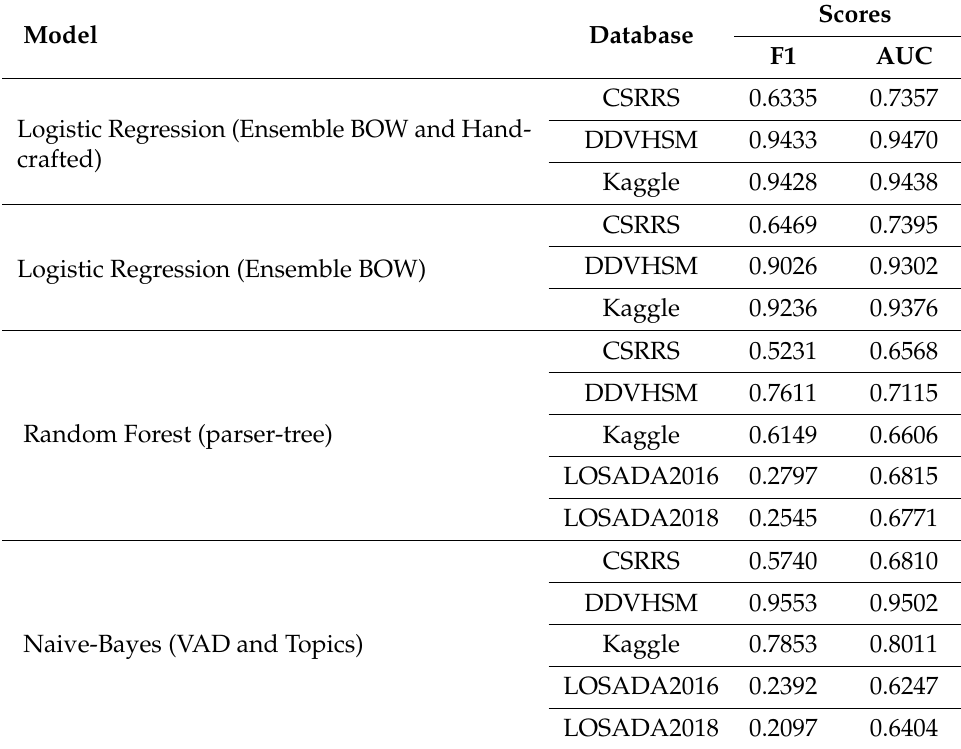
Table 7. Mean F1 and AUC scores for each model